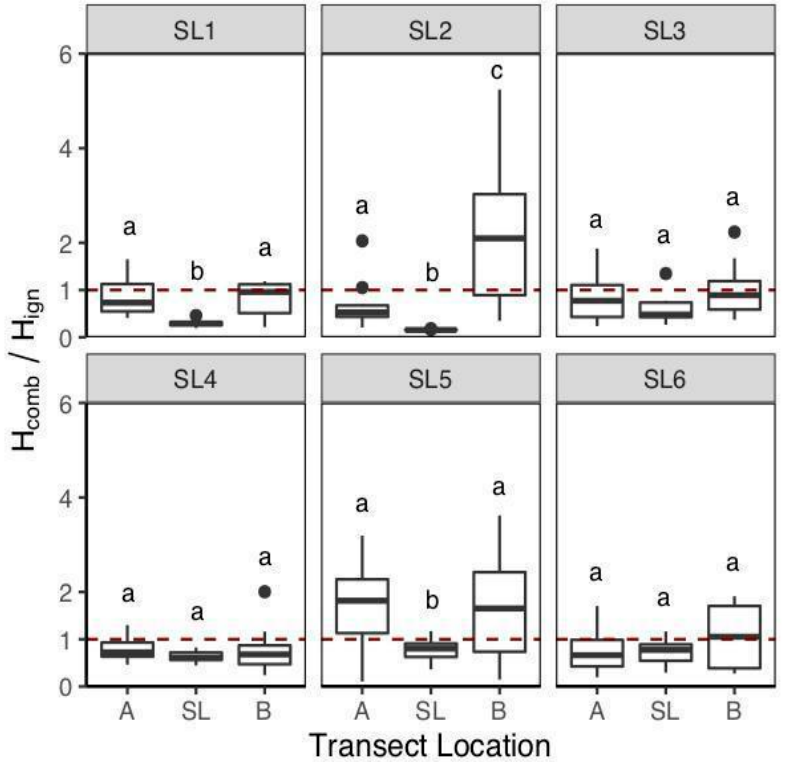
Figure 5. Smouldering potential of near-surface (0–0.06 m) moss and peat where H comb /H ign > 1 indicates potential for smouldering combustion. Transects ‘A’ and ‘B’ are located in the adjacent peatland to the ‘SL’ transect. Letters indicate significant (p < 0.01) differences in H comb /H ign between transects at each site, with no comparison amongst sites.